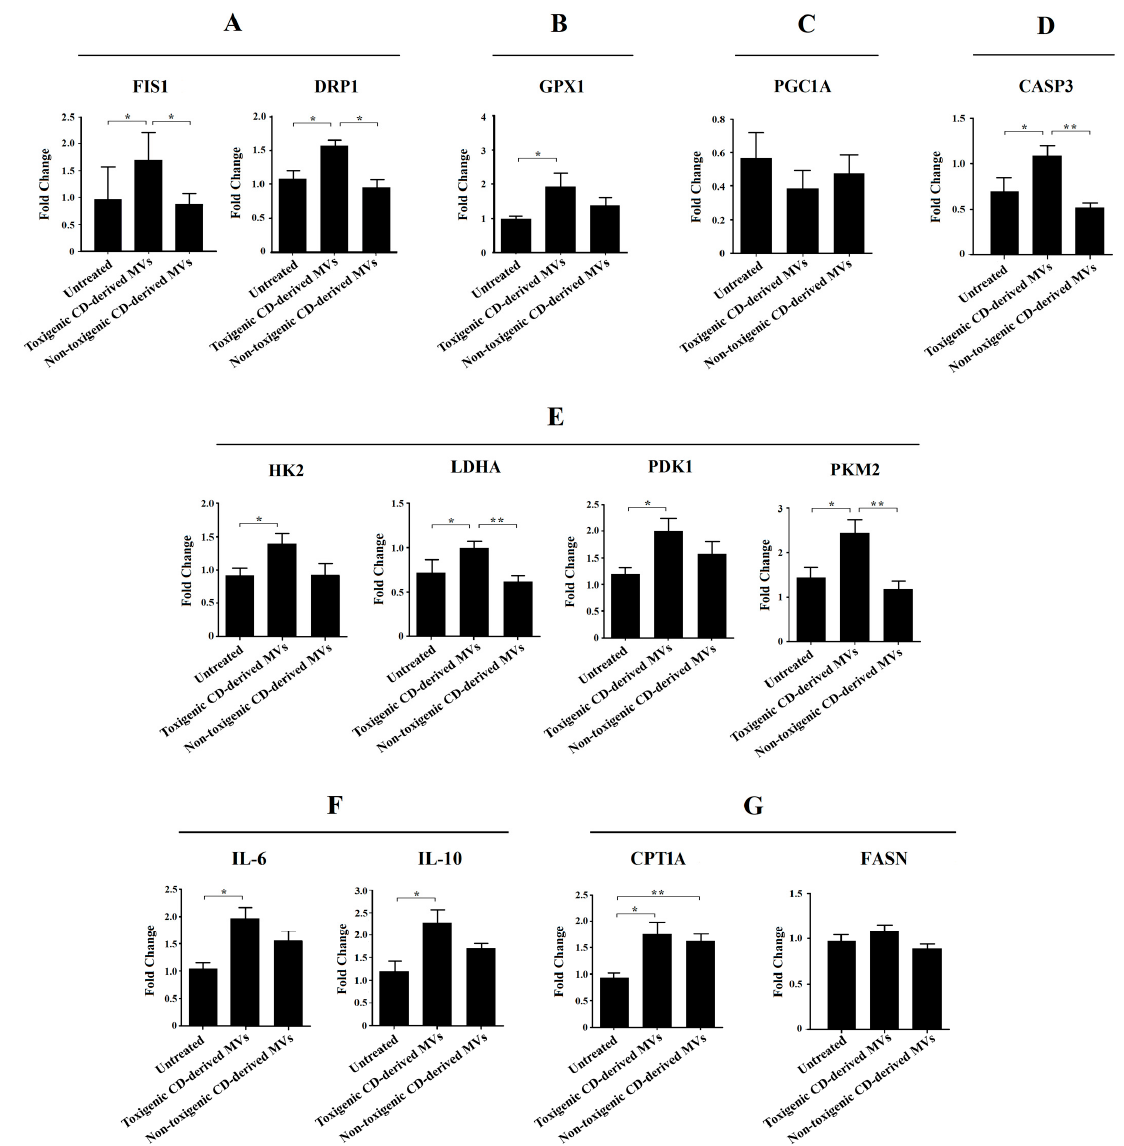
Figure 7. Effects of purified C. difficile -derived MVs (30 µ g total protein/mL) on the expression of genes related to ( A ) mitochondrial fission (FIS1 and DRP1), ( B ) antioxidant state (GPX1), ( C ) mito- chondrial biogenesis (PGC1A), ( D ) apoptosis (CASP3), ( E ) glycolysis (HK2, PKM2, LDHA and PDK1), ( F ) inflammation (IL-6 and IL-10), and ( G ) β -oxidation (CPT1A) and synthesis of fatty acids peroxidase 1. LDHA: lactate dehydrogenase A. HK2: hexokinase 2. PDK1: pyruvate dehydrogenase kinase 1. PKM2: pyruvate kinase M2. PGC1 Α : peroxisome proliferator-activated receptor γ co-acti- vator 1 α . CASP3: caspase 3. CPT1A: carnitine palmitoyltransferase 1A. FASN: fatty acid synthase. IL-6: interleukin-6. IL-10: interleukin-10.